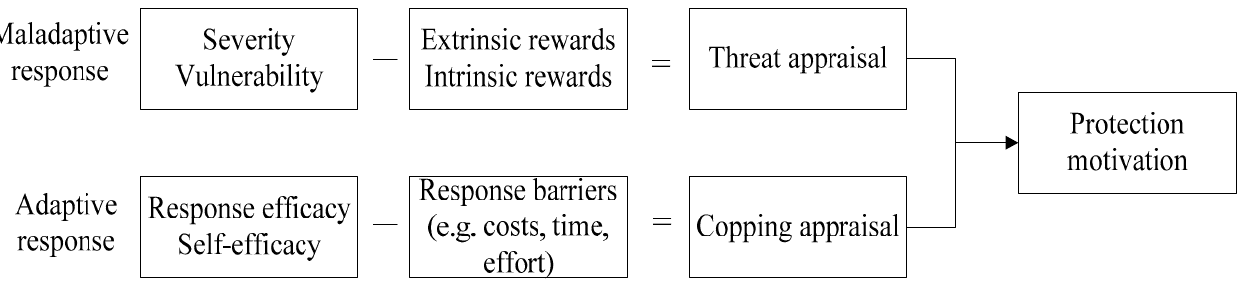
Figure 2. Protection motivation theory. Source: Rogers, 1983.